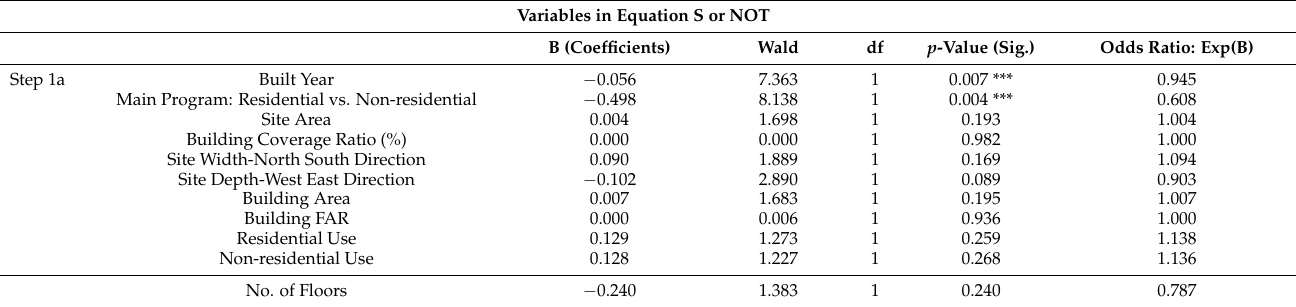
Table 5. Binary logistic regression analysis result: S or